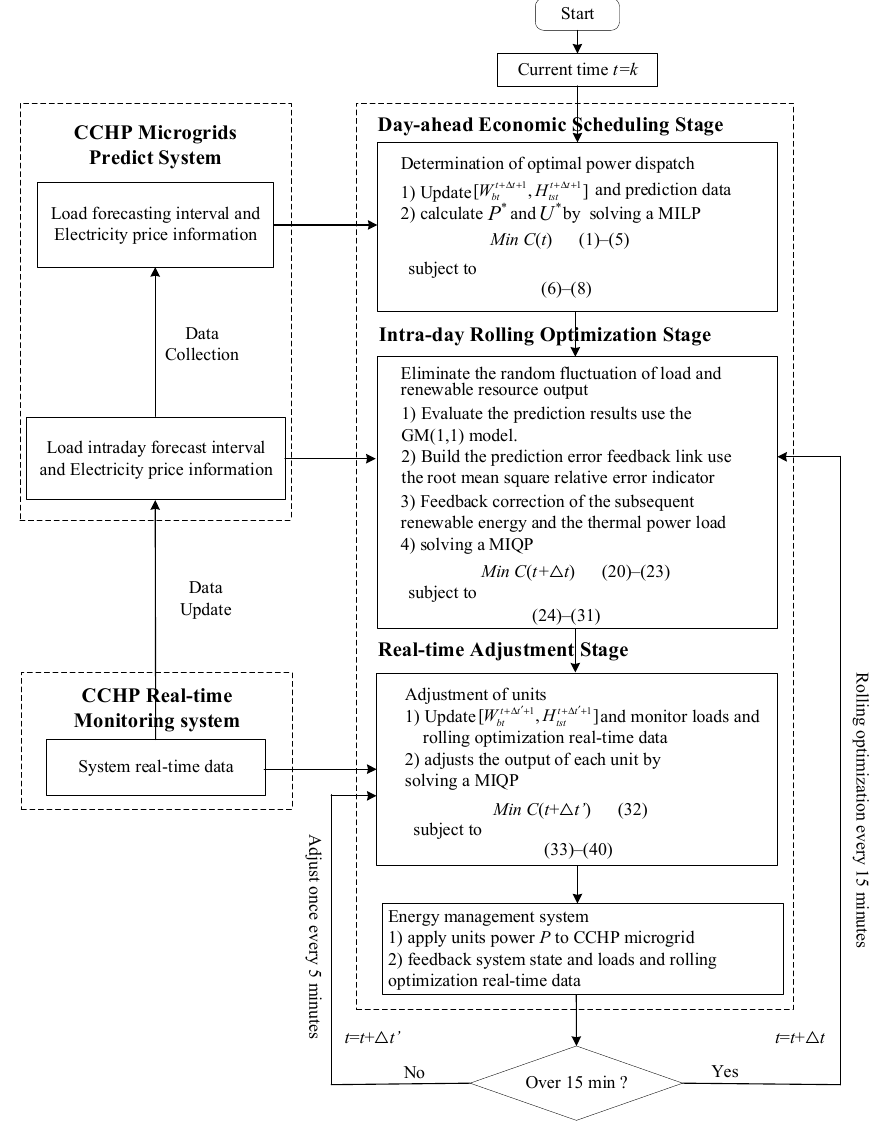
Figure 4. Three-stage optimization energy management structure.